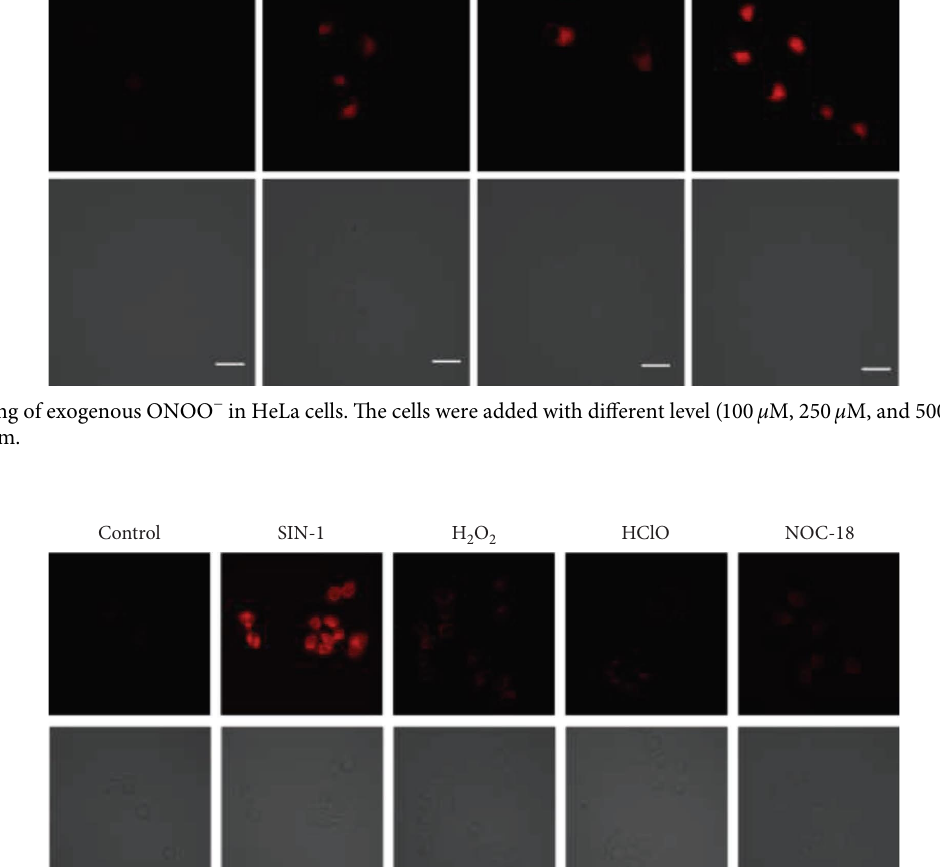
2 O 2 , HClO, NOC-18, and